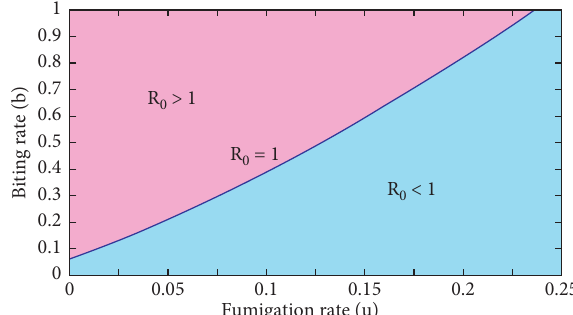
Figure 6: Sensitivity diagram of parameters b � 1. The red colored region defines endemic con- critical line R 0 dition of dengue, and the blue colored area defines dengue-free